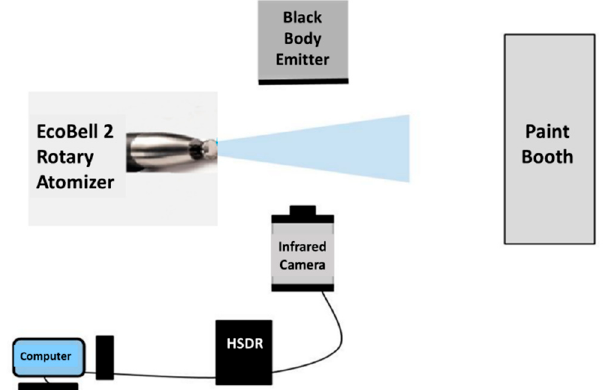
Figure 3. A schematic of the experimental setup for infrared (IR) imaging.